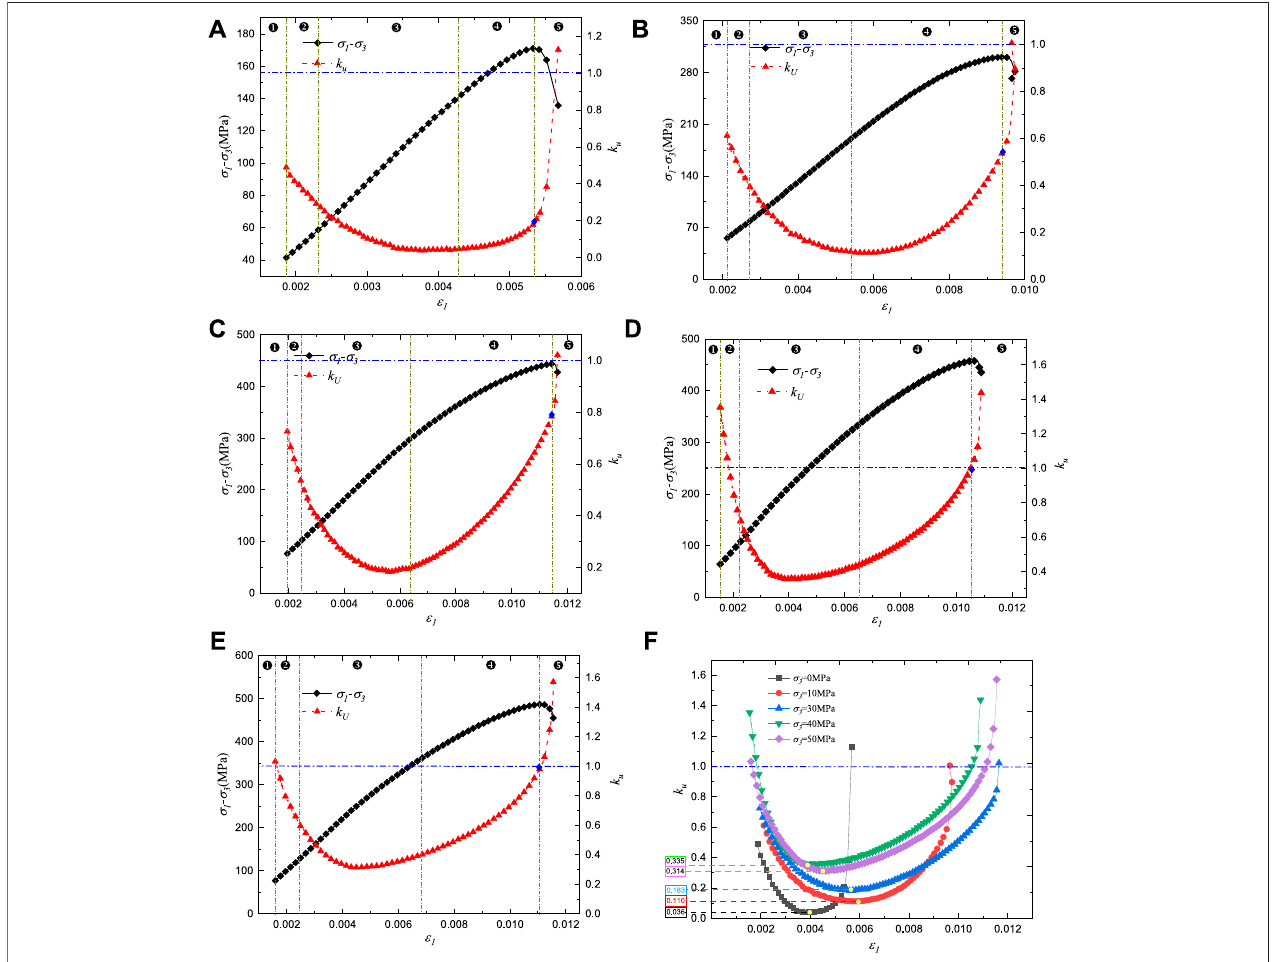
FIGURE 11 | Stress – strain and k u – ε 1 curves under different con fi ning pressures. (A) σ 3 = 0 MPa; (B) σ 3 = 10 MPa; (C) σ 3 = 30 MPa; (D) σ 3 = 40 MPa; (E) σ 3 = 50 MPa; (F) k u – ε 1